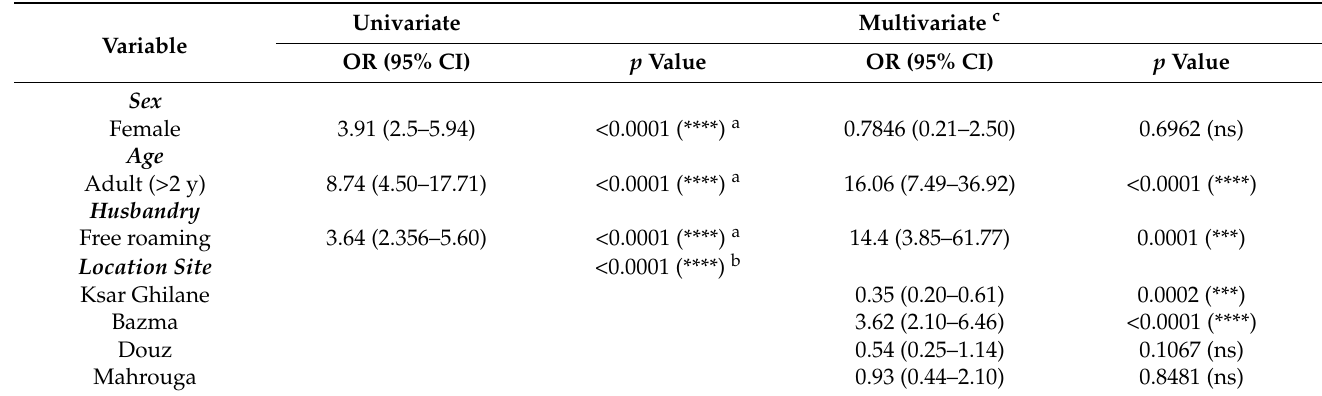
Table 2. Univariate and multivariate analysis of anti- C. burnetii IgG seropositivity. Borderline results were considered negative for statistical